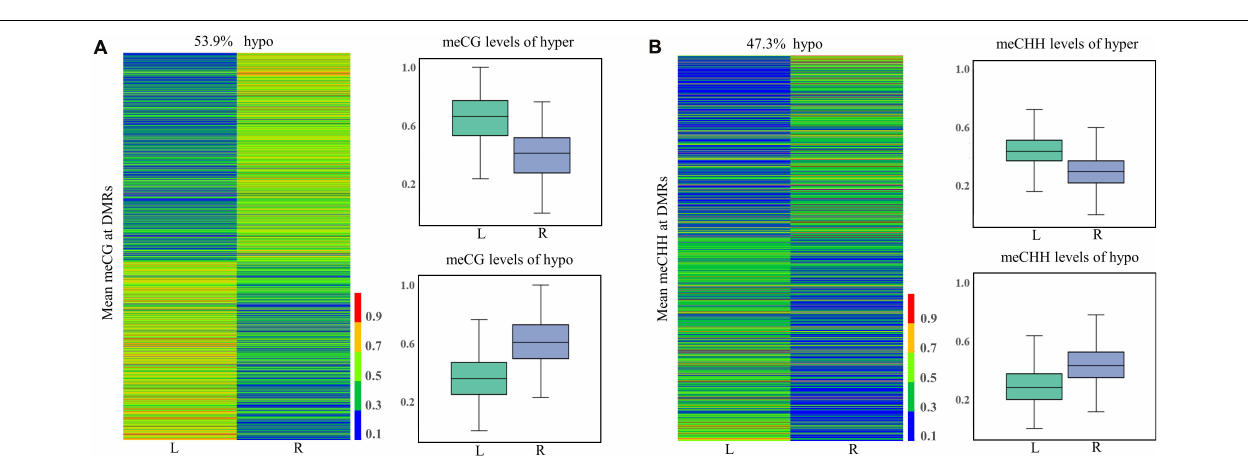
FIGURE 4 | Differentially methylated regions (DMR) dynamics in the left-side (affected-side; L) and the right-side (normal-side; R) mandibular condyle of crossed beaks. Heatmap of DNA methalation profiles and boxplot showing DNA methylation value distribution of DMRs in CG (A) and CHH (B)